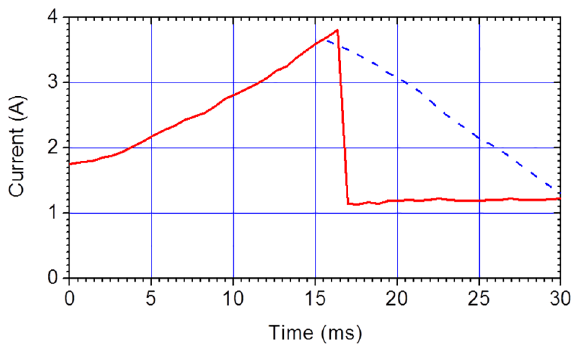
Figure 8. A typical current envelope of a lysis chamber operated under active feedback control of voltage pulse train amplitude. Feedback control of the voltage pulse amplitude in response to real-time chamber impedance measurements maintains the lysis chamber at a near constant temperature after reaching the setpoint at a time of about 16 ms. The dashed (blue) curve indicates the trend of current envelope in the absence of active feedback.